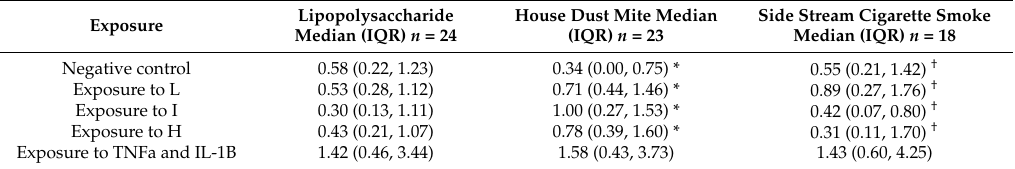
Units are pg per mg protein content of the confluent cellular monolayer. * p = 0.001 from Friedman’s test when three exposure groups and negative control were included; † p = 0.031 for Friedman’s test Table 5. Median and interquartile range (IQR) concentrations of intracellular adhesion molecule across three exposure groups and p = 0.045 for Friedman’s test across three exposure groups plus in supernatants from bronchial airway epithelial cell culture after exposure to lipopolysaccharide negative control. (L = lowest concentration = 1 µ g/mL, I = intermediate concentration = 10 µ g/mL and highest concentration = 100 µ g/mL), house dust mite (L = lowest concentration = 5 µ g/mL, I = intermediate concentration = 25 µ g/mL and H = highest concentration = 50 µ g/mL) and side stream cigarette smoke (concentrations the same as for house dust mite). Exposure Lipopolysaccharide Median (IQR) n = 24 House Dust Mite Median (IQR) n = 23 Side Stream Cigarette Smoke Median (IQR) n = 18